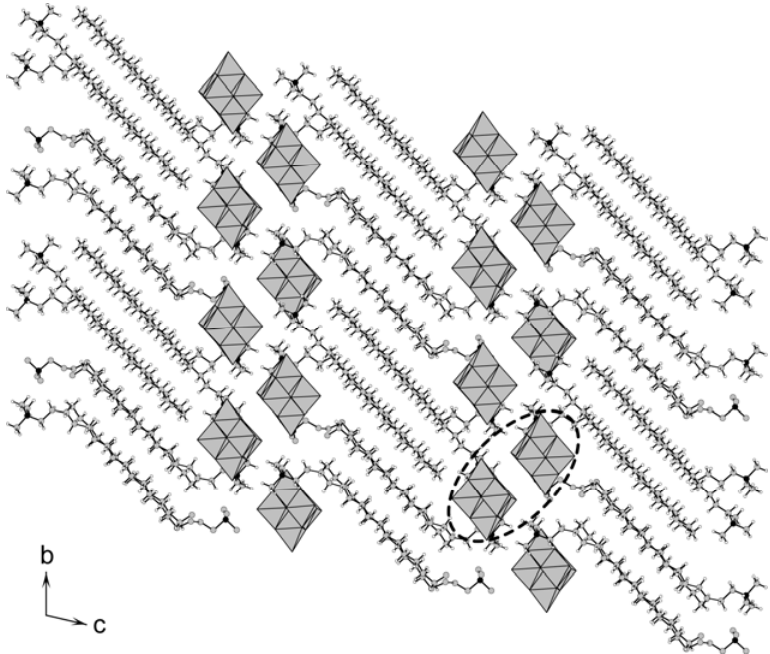
Figure 2. Crystal packing of 2 (C: grey, N: black, H: white; Mo polyhedra). Disordered atoms were omitted for clarity. The broken line indicates a “dimer- anions (see like” structure of the Mo 6